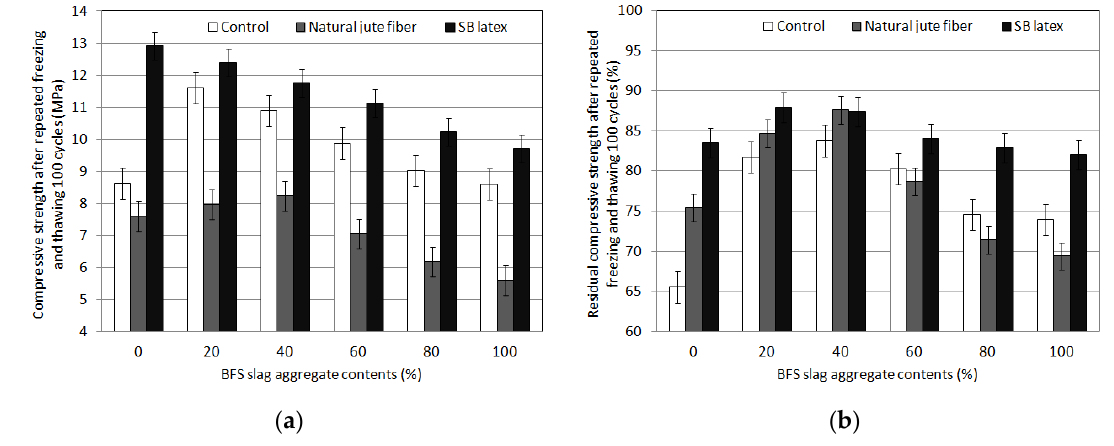
Figure 5. Repeated freezing and thawing cycles test results of porous concrete for plant growth. ( a ) Compressive strength; ( b ) Residual compressive strength.